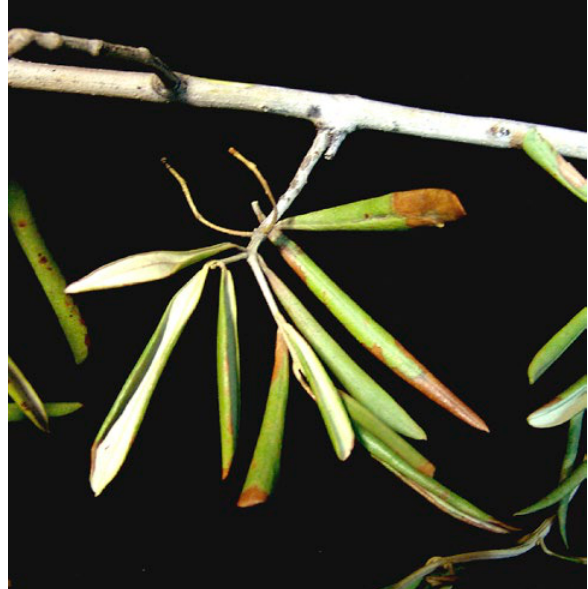
Figure 2. Leaf scorch symptoms observed in olive trees in northern Apulia (Adria, province of